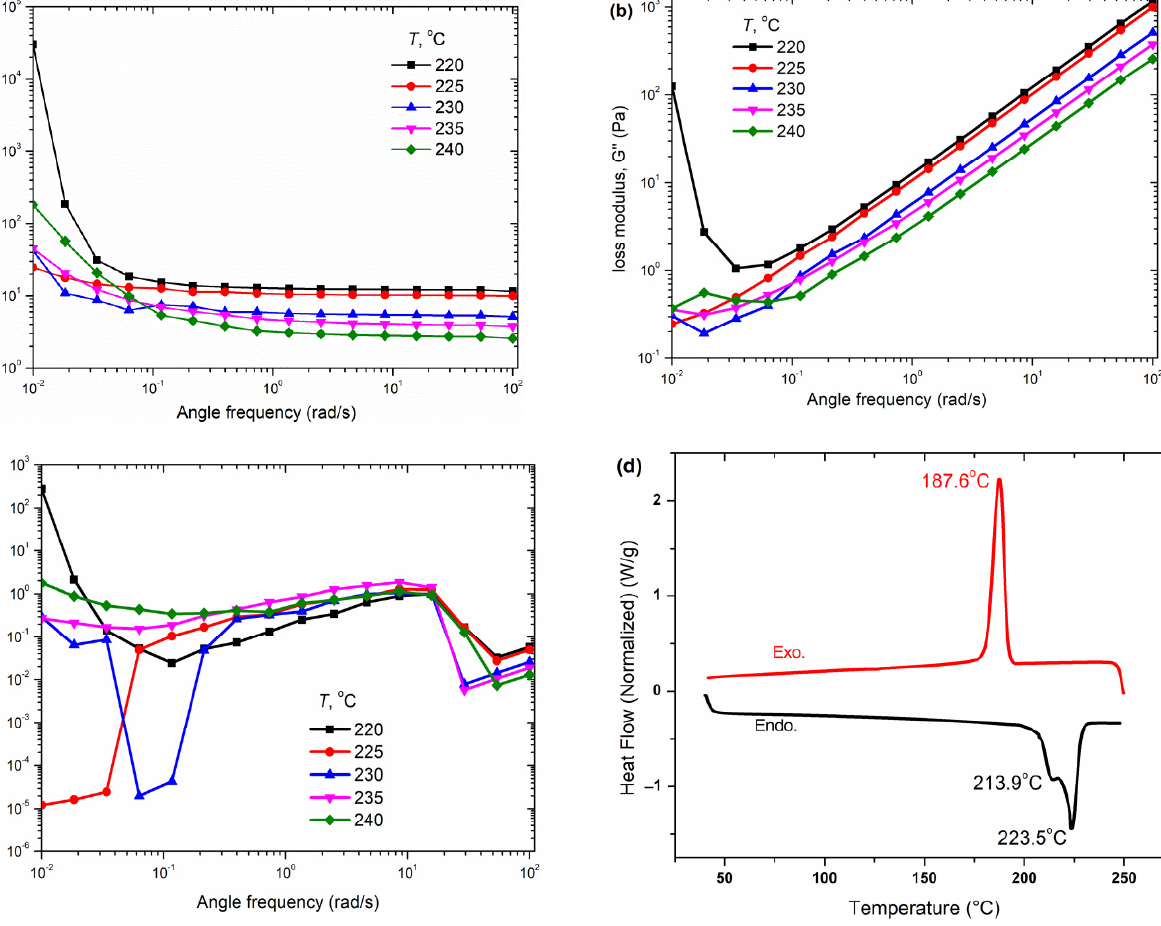
Figure 4. Rheological properties and DSC patterns of pristine PGA melt: ( a ) complex viscosity, ( b ) loss modulus, ( c ) storage modulus and ( d ) the DSC curves of PGA. The G (cid:48) and G ” behave with quite different behaviors with the shear rate, as shown in Figure 4b,c. The G ” of PGA at certain temperature increases with the shear rate, while